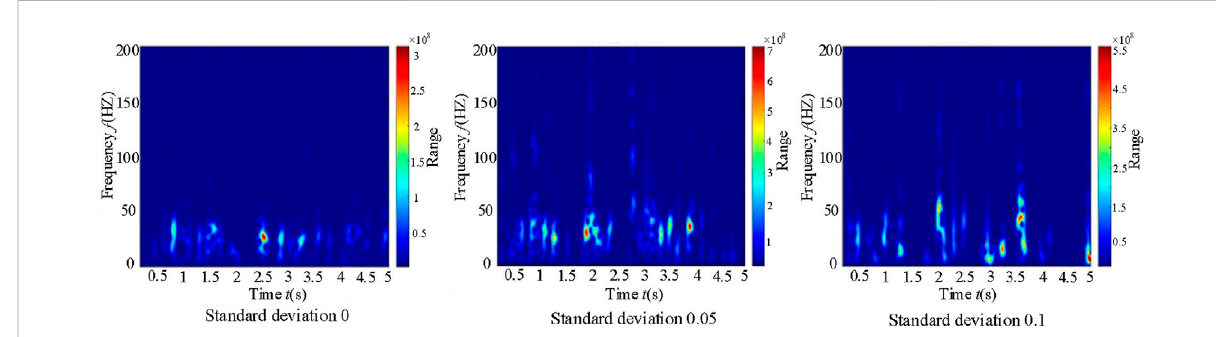
FIGURE 16 Time – frequency spectra of tail beam vibration with different particle distributions.